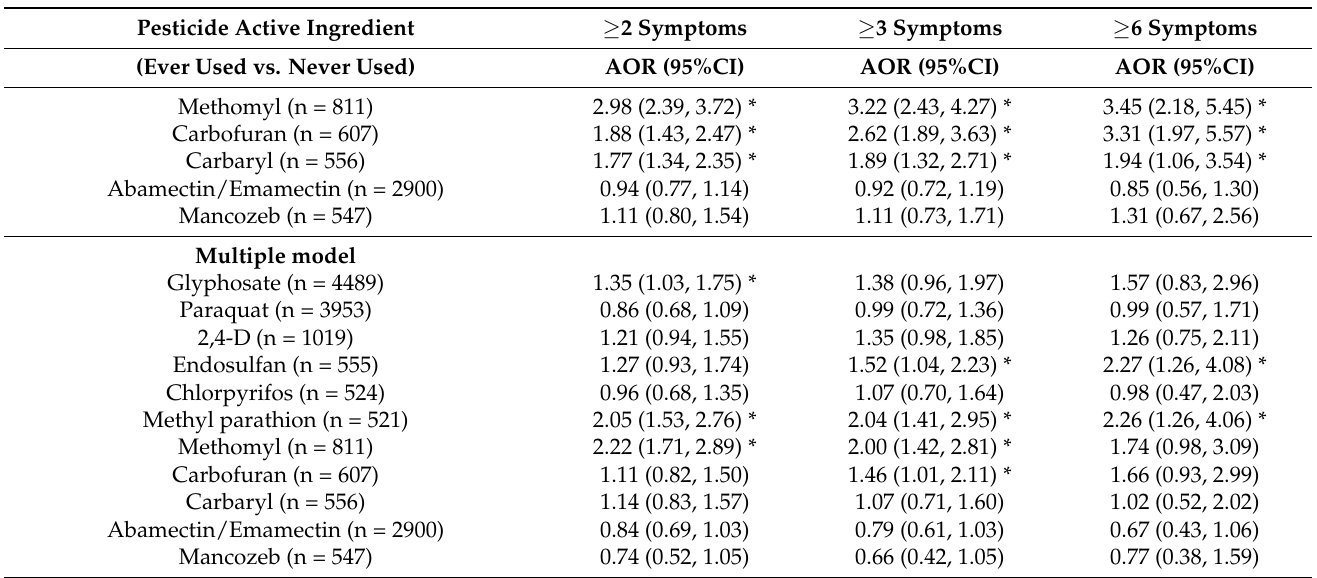
Table 5. Association of individual pesticide exposure with mental disorder in Thai farmers (n = 6974).